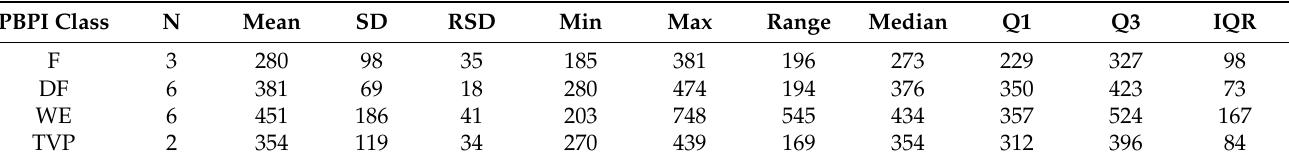
Table 2. Descriptive statistics of the acrylamide content in plant-based protein ingredients (PBPIs) grouped per class.